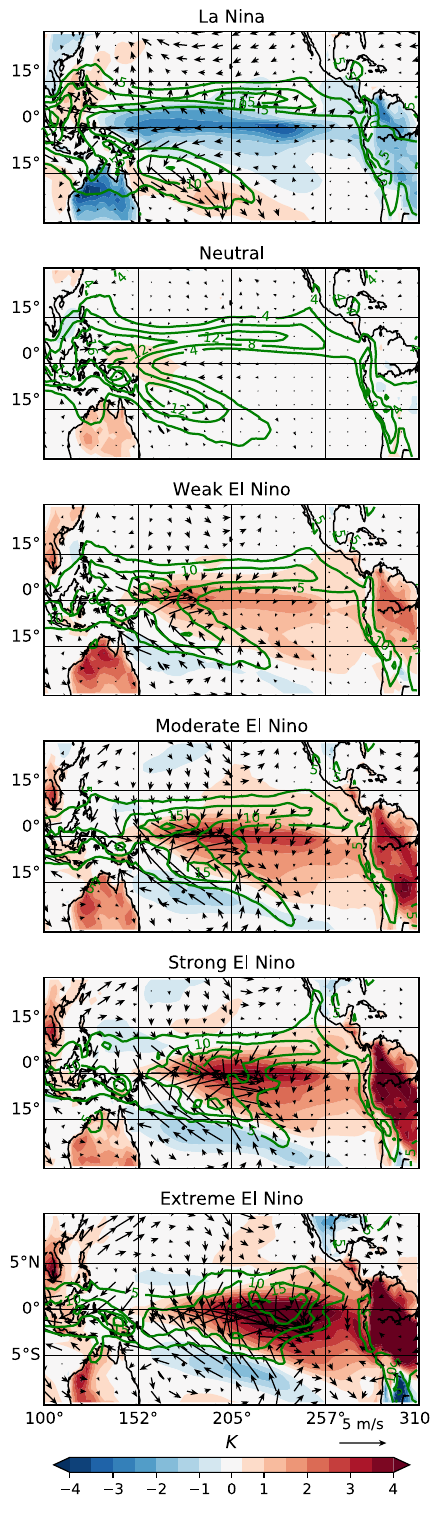
Fig. 6 Selected ENSO groups. Boreal winter control ENSO states at each of the selected control ENSO groups: La Niña, Neutral, weak El Niño, moderate El Niño, strong El Niño, and extreme El Niño are shown as December 1991 monthly mean sea and land surface temperature (K, shading) and wind at 10 m (m/s, arrows) ensemble mean anomalies calculated with respect to the climatology, and total precipitation (mm day − 1 , contours).